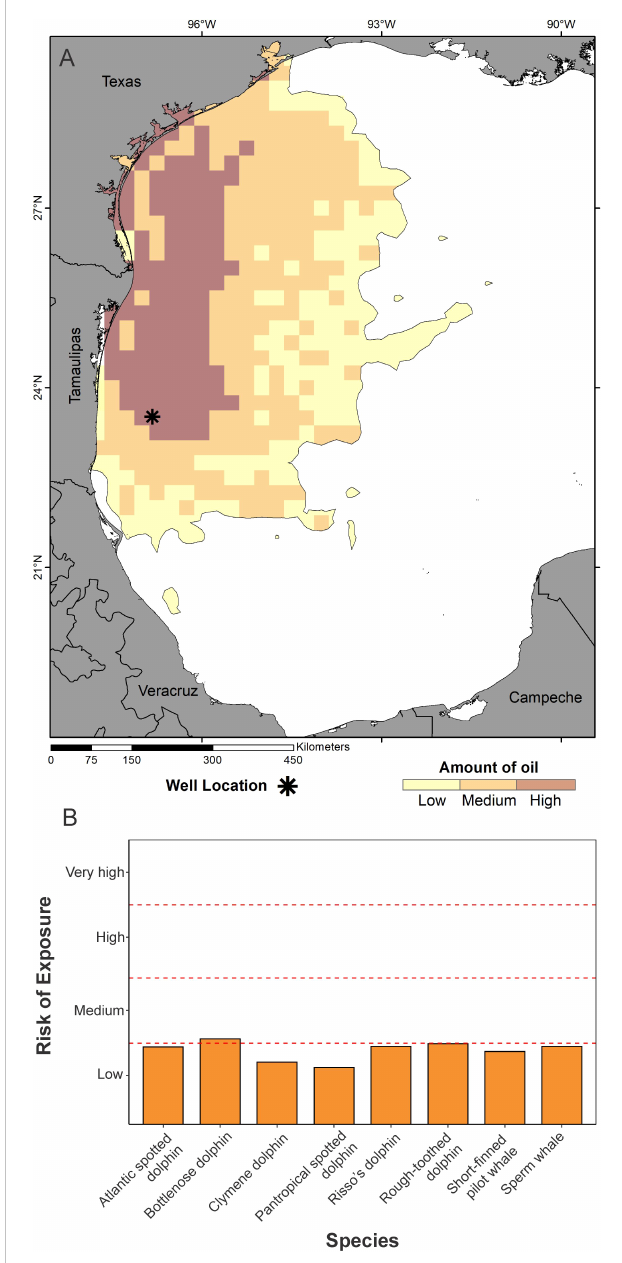
FIGURE 5 (A) Spill scenario for the Tamaulipas well (black asterisk), center-west of the Gulf of Mexico. The amount of oil is ranked as low, medium, and high using quantile breaks of the maximum average mass fraction ( P max ). Based on Pe ́ rez-Brunius et al. (2020). (B) Risk of oil exposure of eight species of